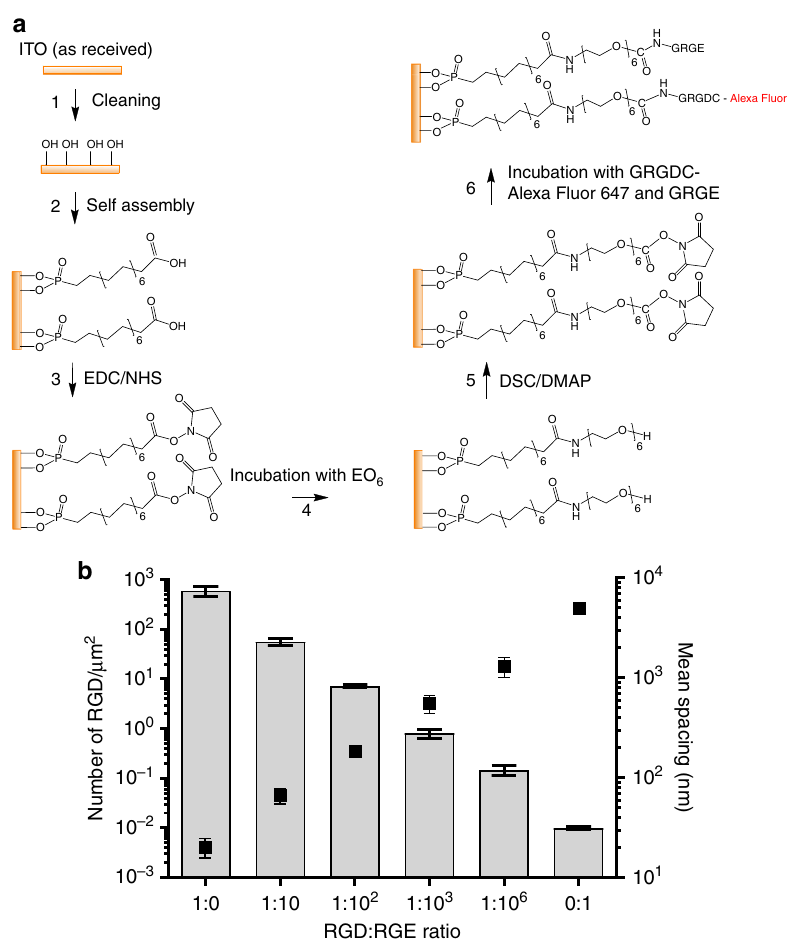
Fig. 2 Multistep surface chemistry to functionalise ITO surfaces to control average RGD spacing. a Schematic of the formation of the interface where the surface density of RGD peptides attached to the otherwise cell-inert surface (facilitated by hexa(ethylene oxide) molecules, EO 6 ) was controlled by controlling the ratio of the molar ratio of GRGDC-Alexa Fluor 647 (RGD) and unlabelled, nonfunctional GRGE (RGE) peptides. b RGD peptides imaged by dSTORM showing the number of RGD per μ m 2 on functionalised ITO surfaces. RGD density was determined from SMLM data of n = 4 independent experiments. Mean spacing was calculated from RGD densities, assuming a spatially random